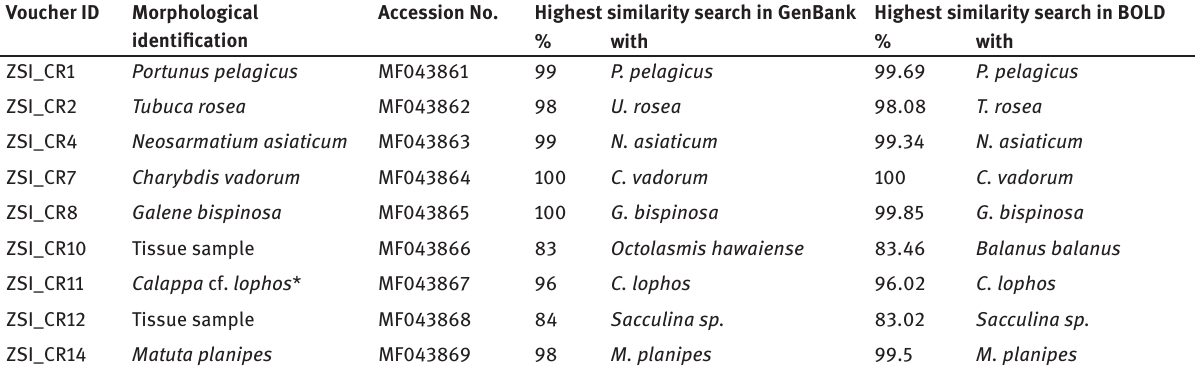
Table 1: Similarity search results of the studied sample in both GenBank and BOLD database. Voucher ID